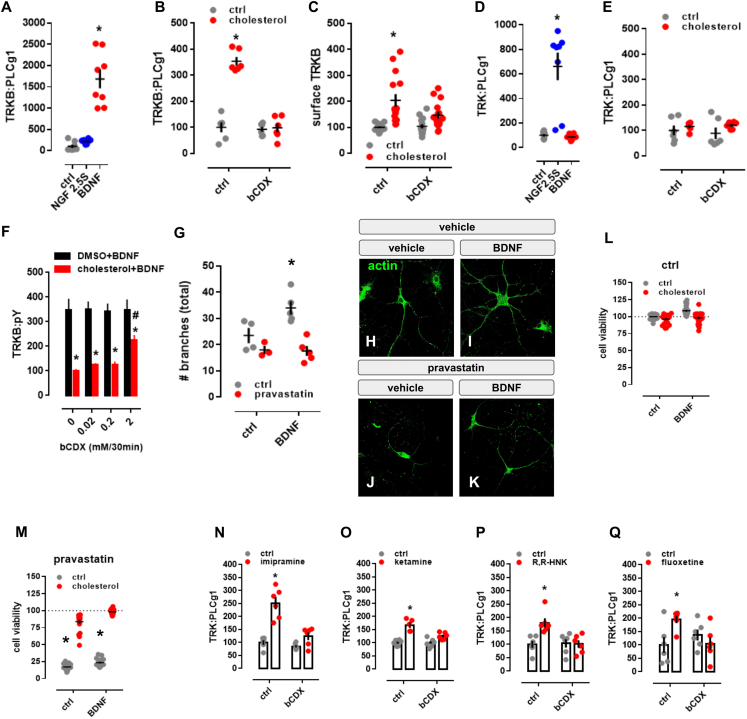
Cholesterol sensing by TRKB, related to Figure 1(A-E) MG87 cells were treated with β-cyclodextrin (bCDX), NGF, BDNF, or cholesterol and the levels of TRKB:PLC-γ1 or surface TRKB determined by ELISA. In MG87 cells expressing TRKB, (A) BDNF (10ng/ml/15min), but not NGF (50ng/ml/15min), increases the TRKB:PLC-γ1 interaction [treatment: F(2,21) = 46.24; p = 0.0001] measured by ELISA. The effect of cholesterol (20μM/15min) on (B) TRKB:PLC-γ1 coupling [interaction: F(1,20) = 59.49; p = 0.0001] and (C) surface positioning of TRKB [interaction: F(1,54) = 4.202; p = 0.04] is counteracted by pre-treatment with beta-cyclodextrin (bCDX; 2mM/30min). In MG87 cells expressing TRKA, (D) NGF, but not, BDNF, increases the TRKA:PLC-γ1 coupling [treatment: F(2,21) = 25.29; p = 0.0001]. (E) Lack of effect of cholesterol-induced TRKA:PLC-γ1 in cells expressing TRKA [interaction: F(1,20) = 0.25; p = 0.64]. (F) Rat cortical cells were treated with different concentrations of bCDX (30min), challenged by a combo of cholesterol+BDNF (15min), and the levels of TRKB:pY was determined by ELISA. β-cyclodextrin (mM/30min) reverses the block of BDNF-induced pTRKB (10ng/ml/15min) by high cholesterol concentration (100 μM/15min) [F(1,40) = 96.95, p < 0.0001, n = 6/group]. (G) Rat hippocampal cells were treated with pravastatin and BDNF, fixed and stained for actin. Effect of pravastatin (1μM/3days) on BDNF-induced neurite branching (10ng/ml/3days); interaction: F(1,13) = 4.967, p = 0.0441, n = 3-5]. (H-K) representative images of pravastatin effect on BDNF-induced branching. (L,M) Rat cortical cells were treated with pravastatin, cholesterol and BDNF, and the cell viability determined by CellTiterGlo. Pravastatin-induced cell death (2 μM/5days) is counteracted by co-incubation with cholesterol (20μM/5days) and BDNF (10ng/ml/5days) [interaction: F(1,164) = 10.895, p = 0.001, n = 20-24]. Data expressed as mean ± SEM of percentage from ctrl group. ∗p < 0.05 from the control group (Fisher’s LSD). (N-Q) Rat cortical cells were treated with β-cyclodextrin (bCDX) or antidepressants, and the levels of TRKB:PLC-γ1 determined by ELISA. The pretreatment with bCDX (2mM/30min) prevents the increase in TRKB:PLC-γ1 (PLCg1) induced by (N) imipramine [interaction: F(1,20) = 14.71, p = 0.0010, n = 6/group], (O) ketamine [interaction: F(1,19) = 9.335, p = 0.0065, n = 5-6], (P) R,R-HNK [interaction: F(1,20) = 8.033, p = 0.0102, n = 6/group] or (Q) fluoxetine [interaction: F(1,20) = 8.035, p = 0.0103, n = 6/group]. ∗p < 0.05 from the control group (Fisher’s LSD).